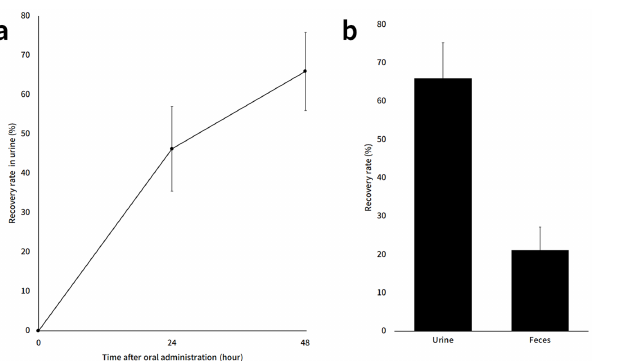
Fig 5. The recovery rate of 15 N from DNJ in urine and feces until 48 hours after sample administration. After 12 hours fasting, the rats were received 15 N-labeled DNJ (10 mg). Urine and feces were collected and the amount of 15 N from DNJ was analyzed. (a) The time course of recovery rate of 15 N in urine. (b) Total recovery rate of 15 N in urine and feces. Results are given as means ±